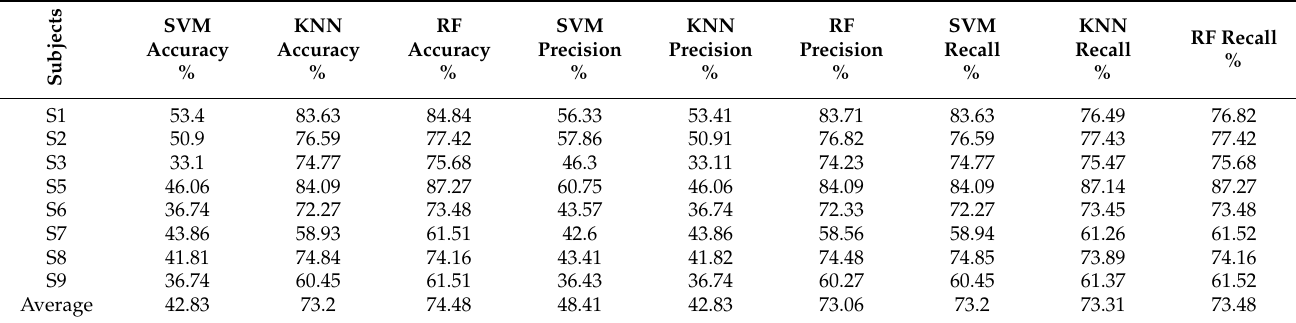
Table 7. Performance comparison of SVM, KNN, and RF classifiers from four classes (left hand, right hand, feet, and tongue) of eight subjects